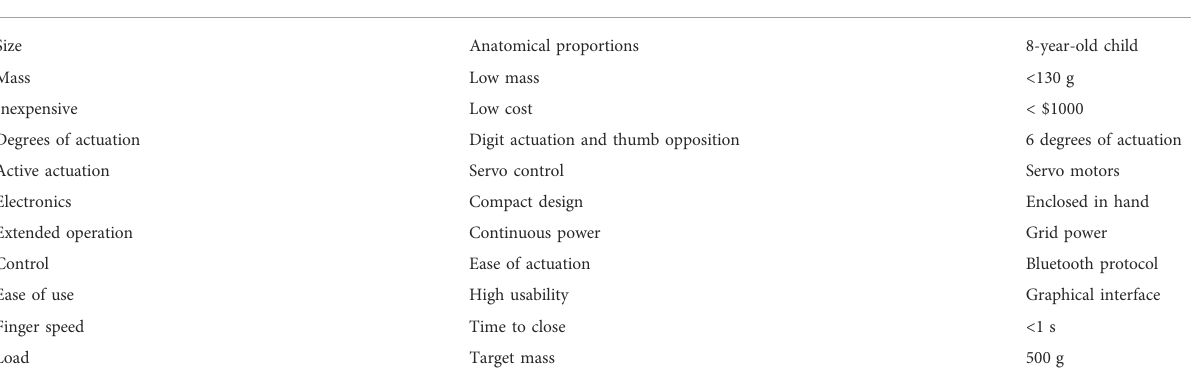
TABLE 1 Pediatric research platform design